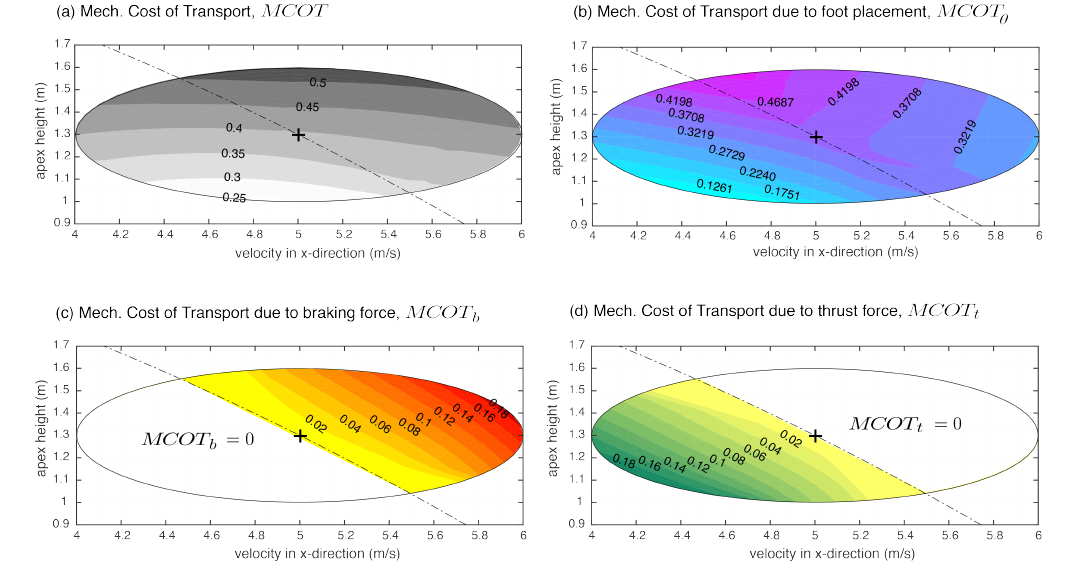
Figure 4. Contour plots for mechanical cost of transport (MCOT) function of horizontal velocity and apex height. ( a ) Total MCOT; ( b ) MCOT due to foot placement angle θ ; ( c ) MCOT due to braking force P b ; and ( d ) MCOT due to thrust force P t